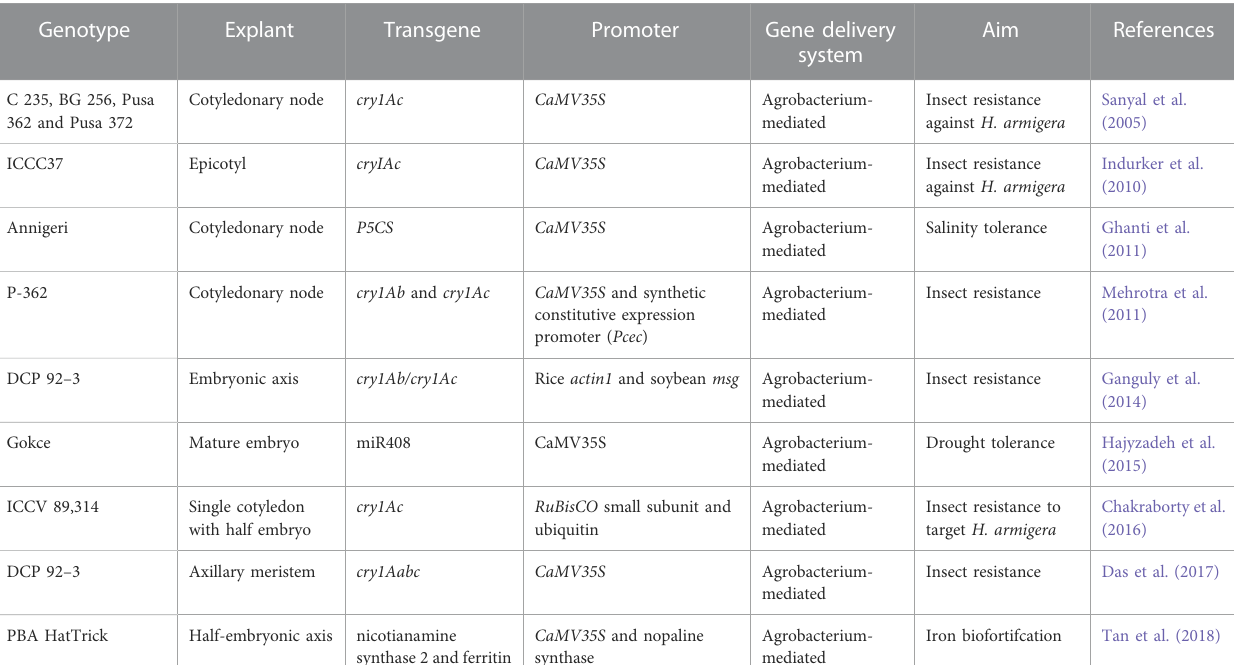
TABLE 1 Genetic transformation of